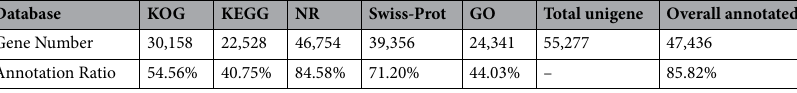
Table 1. Unigene Annotation date 32,33